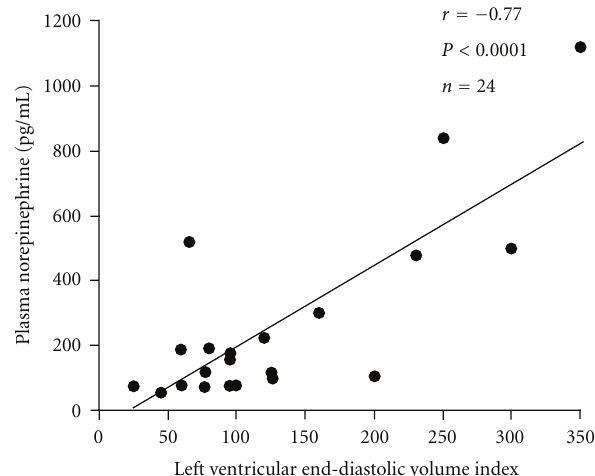
Figure 3: Sympathetic activation and cardiac remodelling in chagas disease. Norepinephrine serum levels are directly related to the left ventricular end-diastolic volume index. Patients with normal-sized left ventricles have no increased serum levels of norepinephrine. Thus, sympathetic activation is secondary to the process of cardiac remodelling (see [32], adapted with permission from